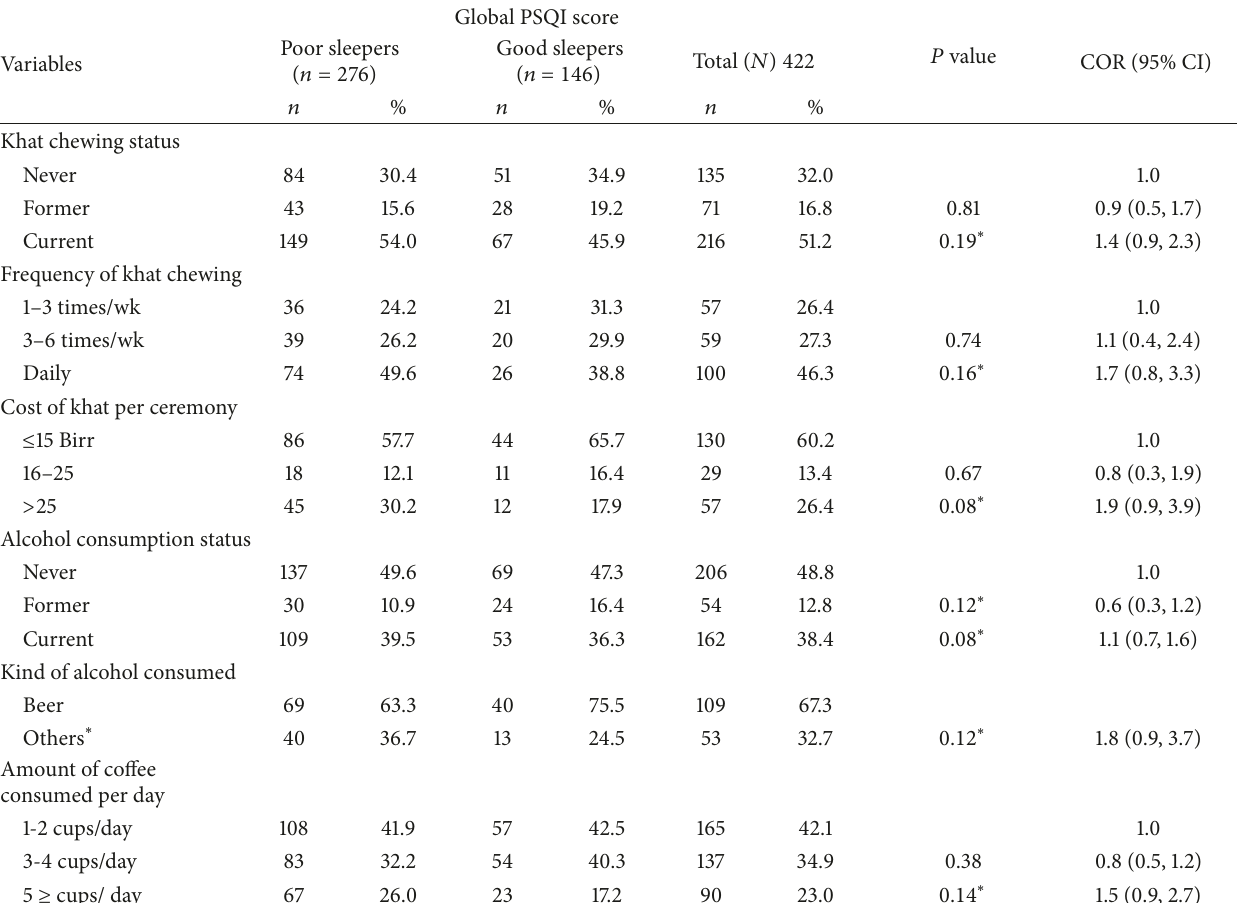
Table 4: Substances use and its association with sleep quality among adults in Jimma town, southwest Ethiopia, April 2016.